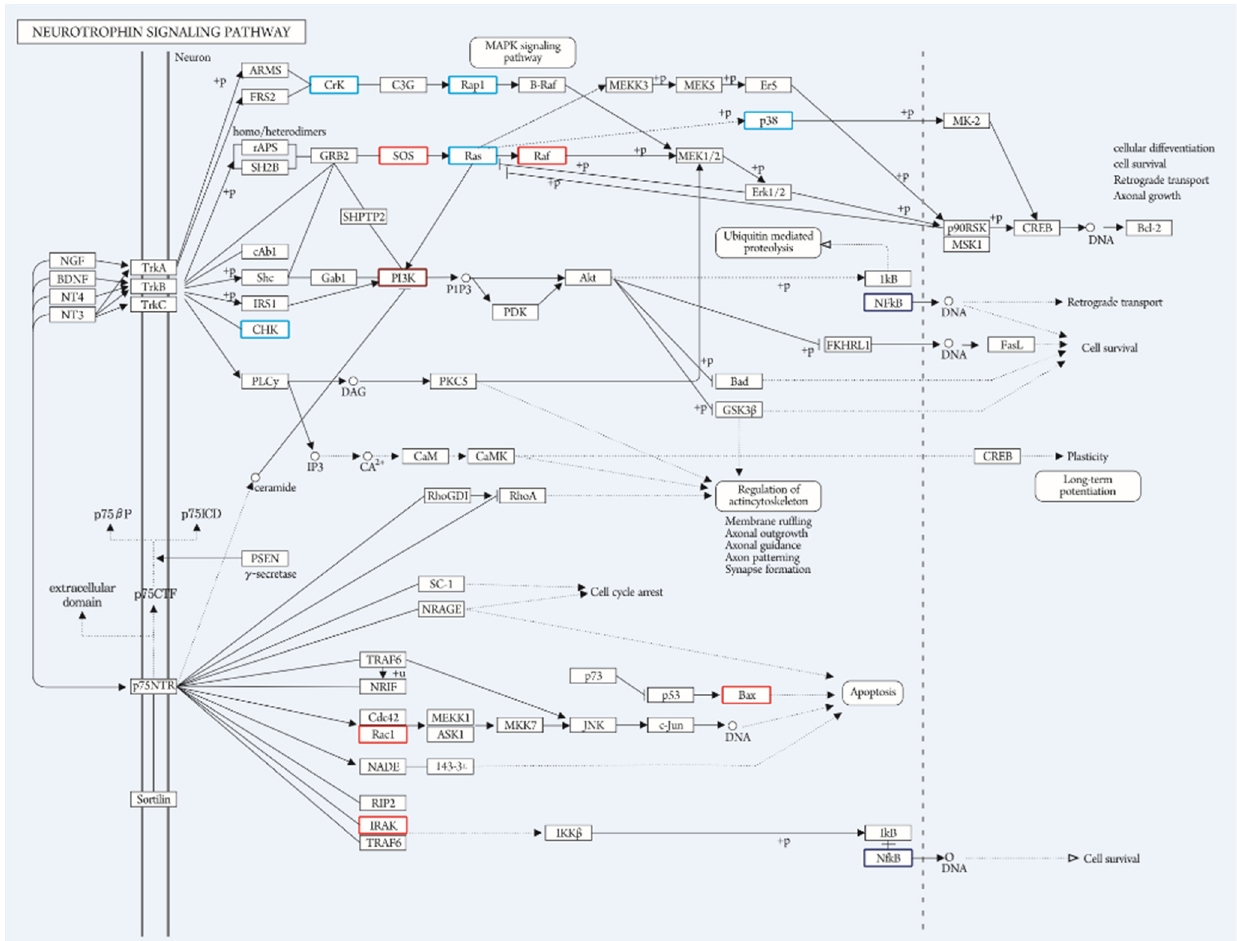
Figure 4. KEGG Mapper Tool Analysis. This figure represents the neurotrophin signaling pathway after tDCS (coral: upregulation, blue: downregulation). Compared with the control group, the upregulated genes in the stimulation group after tDCS were SOS, Raf, PI3K, Rac1, IRAK, and Bax ( p < 0.05). Compared with the control group, the downregulated genes in the stimulation group after tDCS were CHK, Crk, Rap1, p38, Ras, and NF-kB ( p <